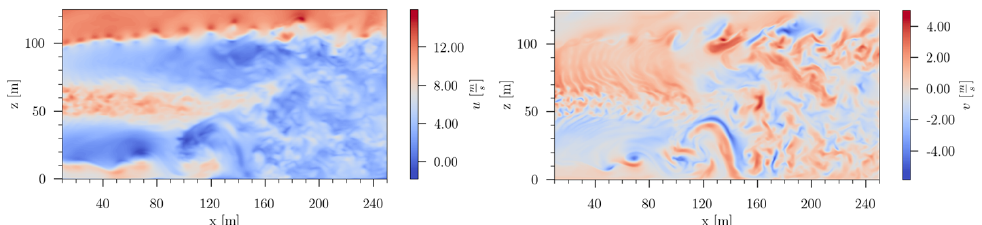
Figure 2. Flow field in the wake of a rotating wind turbine showing the complex characteristics of the flow